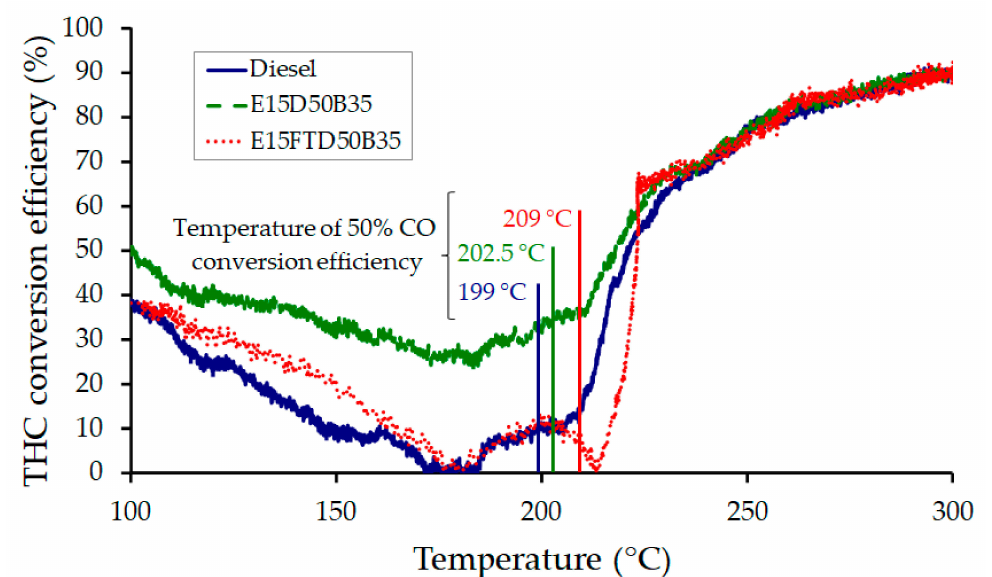
Figure 9. Total hydrocarbons (THC) light-off curves from diesel, E15D50B35, and E15FTD50B35 combustion at 2 bar IMEP and 1500 rpm.